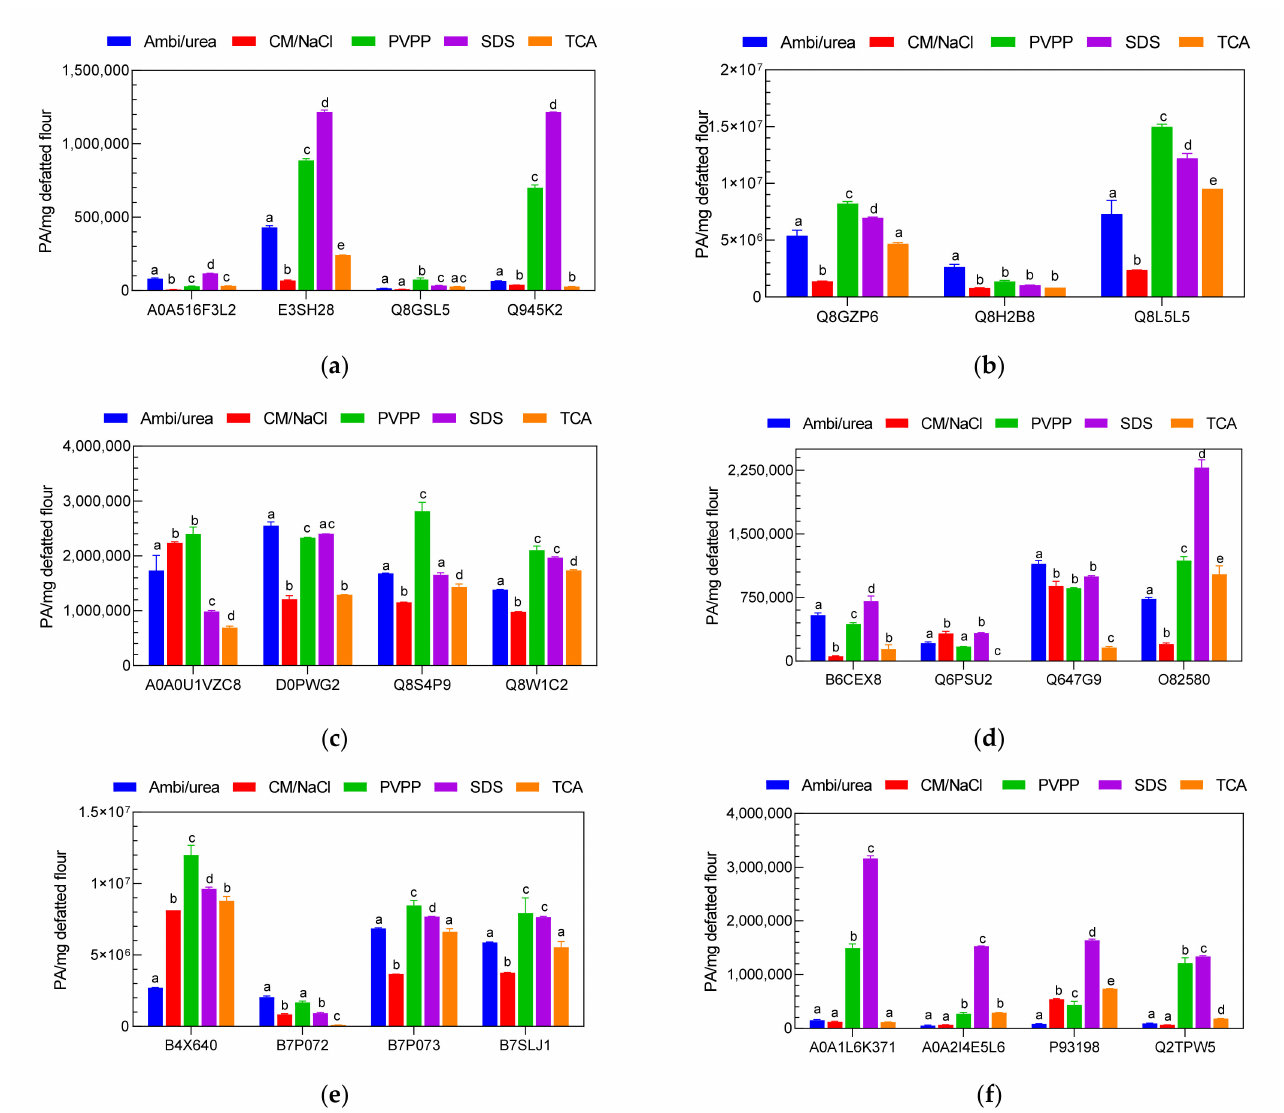
Figure 4. Relative amount of selected allergenic proteins of ( a ) almond, ( b ) cashew, ( c ) hazelnut, ( d ) peanut, ( e ) pistachio and ( f ) walnut expressed as peak area per mg of defatted nut flour according to the different extraction protocols: ammonium bicarbonate/urea (Ambi/urea), chloroform/methanol/sodium chloride (CM/NaCl), polyvinylpolypyrrolidone (PVPP), sodium dodecyl sulfate (SDS) and trichloroacetic acid (TCA). The quantification was performed using the different biomarkers for each protein as determined through method development. Overnight tryptic conventional digestion was performed for all the samples and the experiments were carried out in triplicate ( n = 3). Comparisons were performed per family and different lowercase letters indicate significant differences at p = 0.05 (Tukey